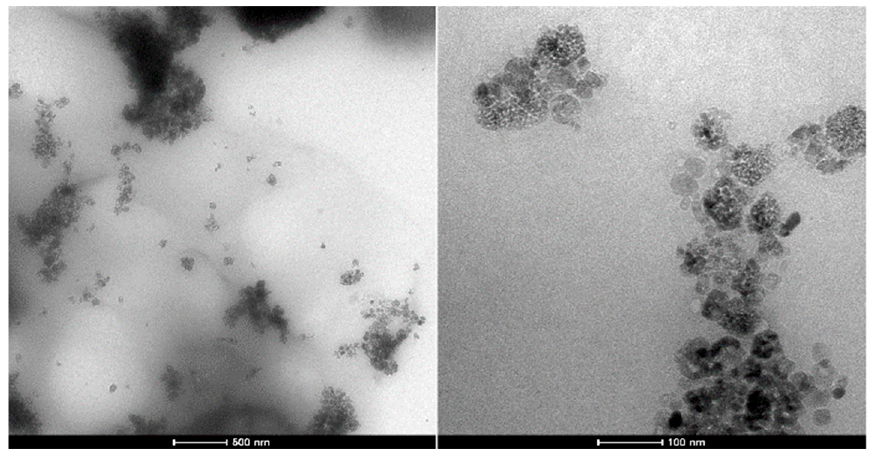
Figure 4. Transmission electron microscopy (TEM) images of PVB/TiO 2 (10 wt.%) composite.